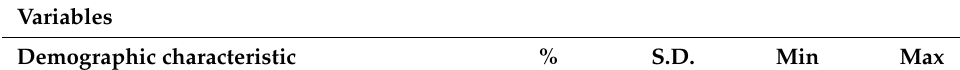
Table 1. Descriptive Analysis ( N =